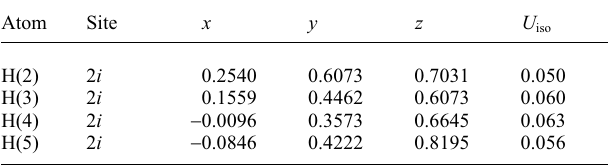
Table 2. Atomic coordinates and displacement parameters (in Å 2 )